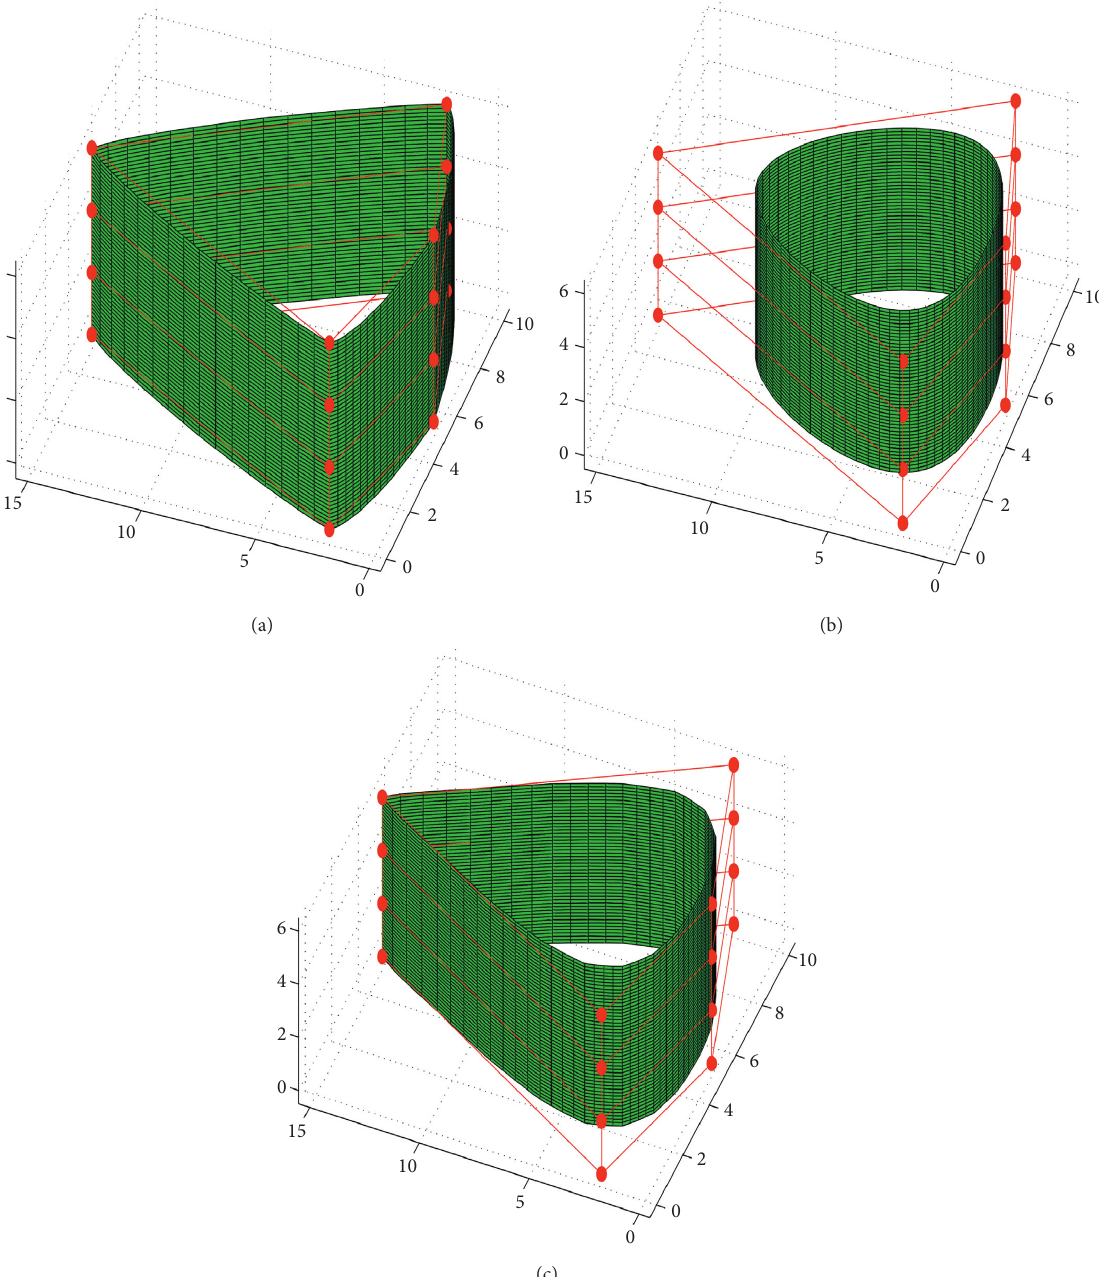
Figure 11: The effect of local interpolation by tensor product of our combined subdivision scheme S